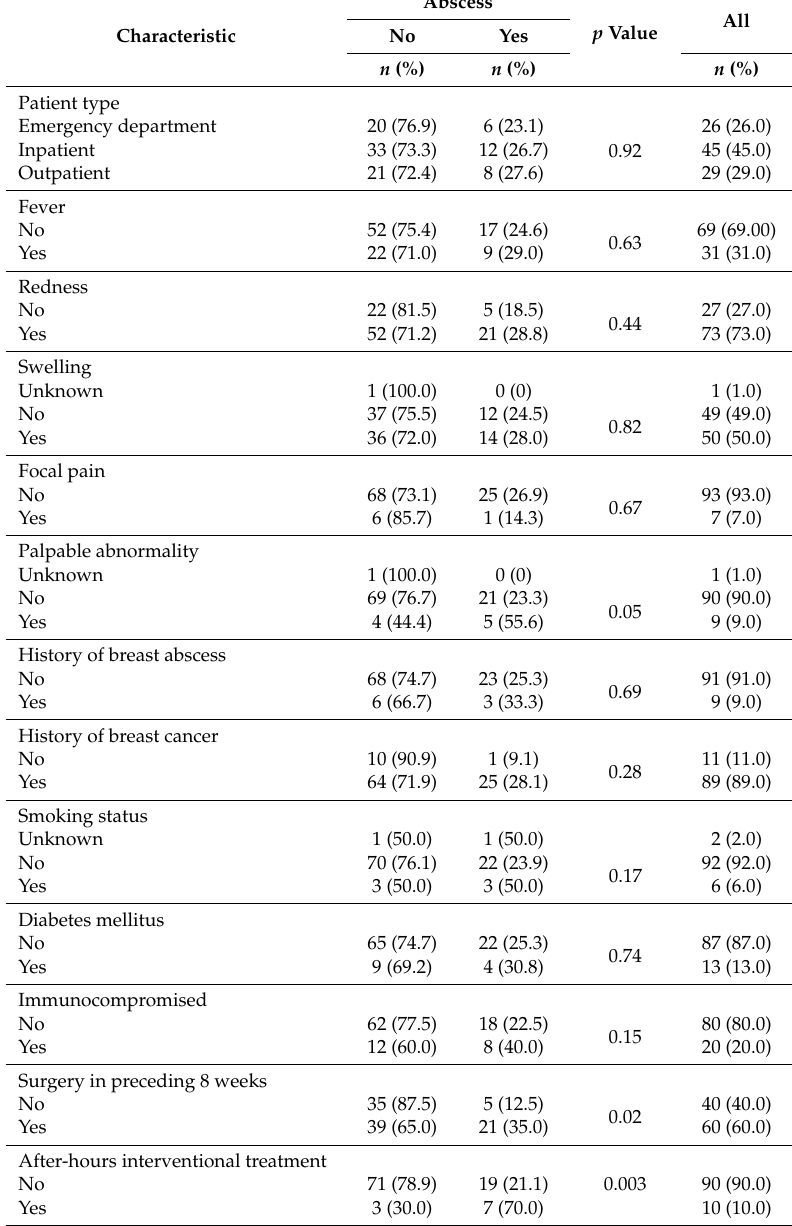
Table 1. Patient characteristics overall and by abscess